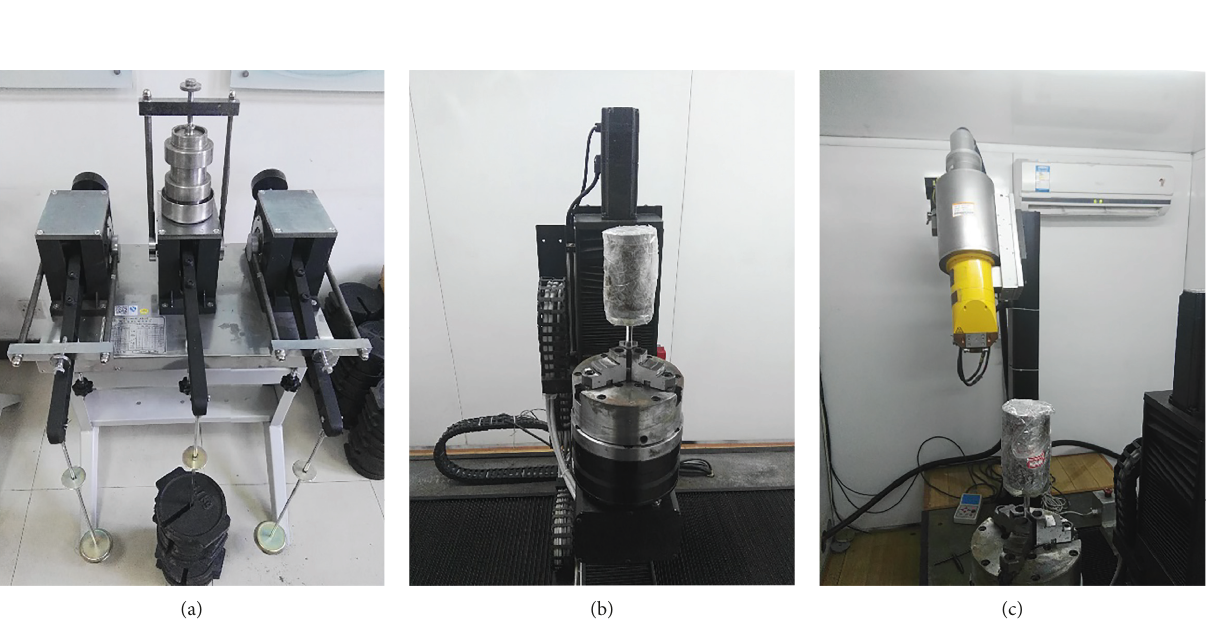
Figure 2: Sample preparation process.